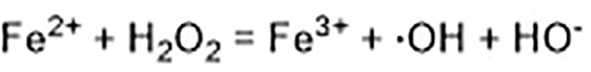
Fenton reaction.